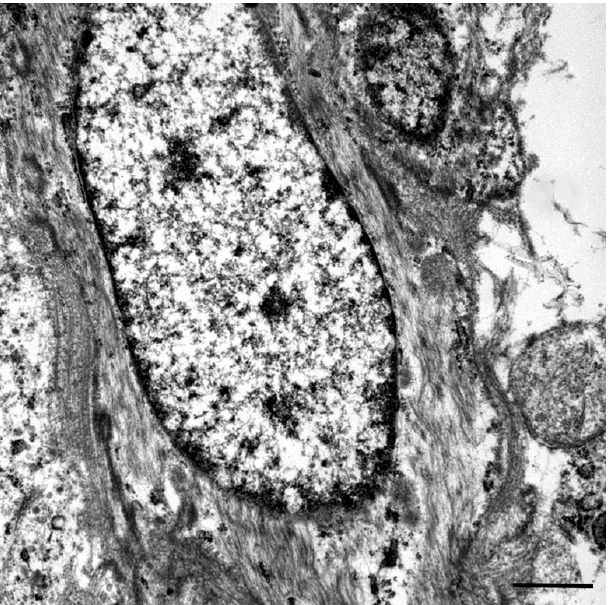
Figure 4. Inflammatory myofibroblastic tumor, abdominal mass, cat. Note the fibrillar cytoplasmic appearance of an atypical spindle cell. Size bar = 1 micron. TEM.